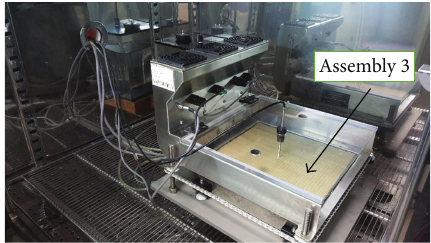
Figure 3: Water vapour resistance measurement using sweating guarded-hotplate